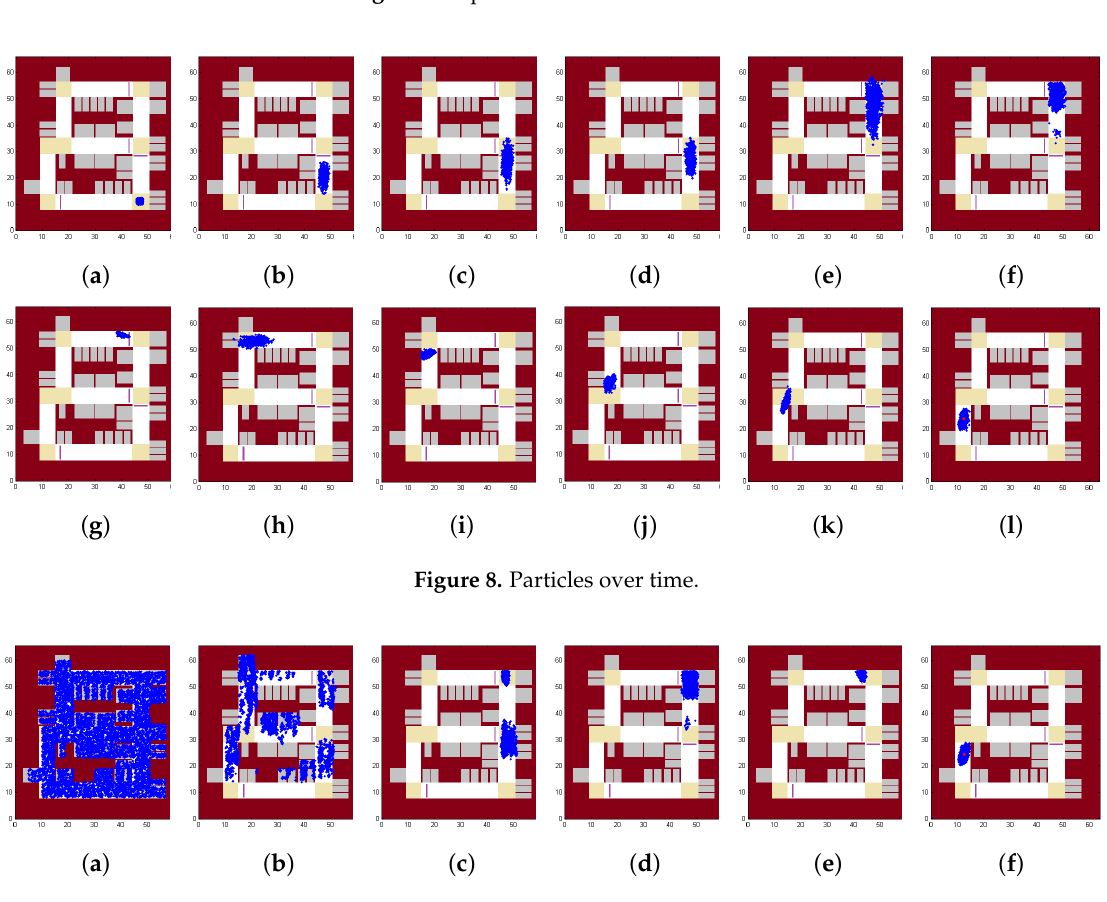
Figure 9. Particles over time without the initial